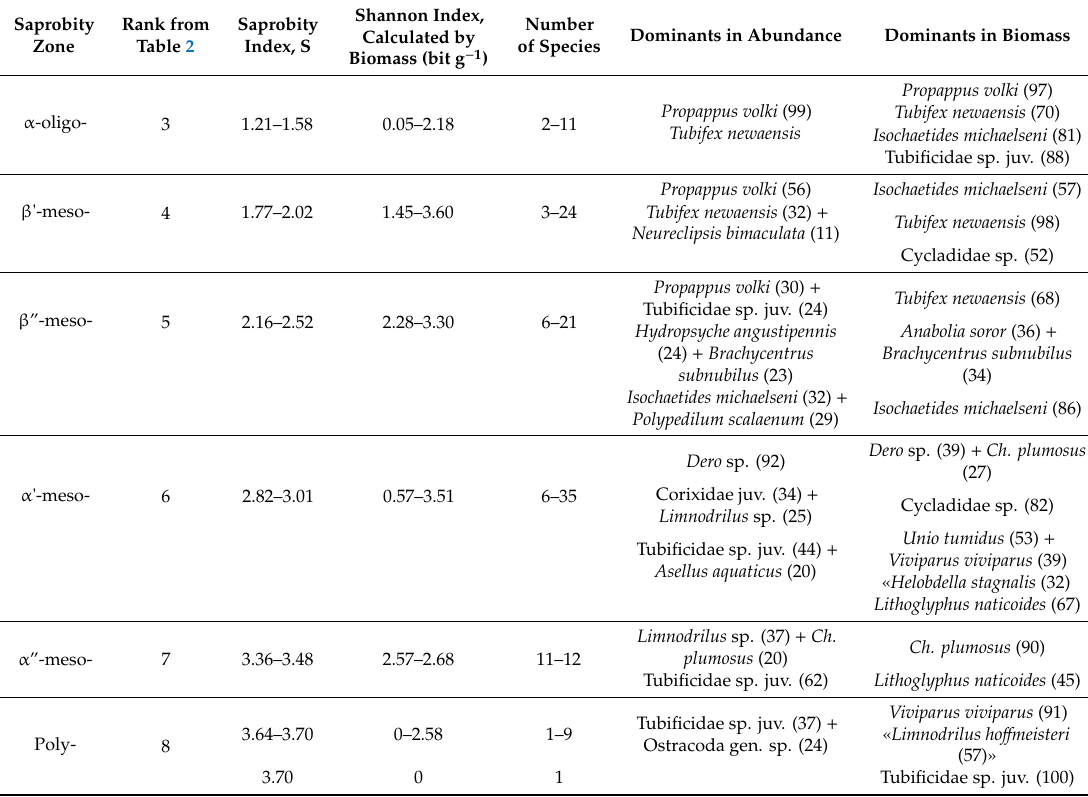
Table 4. Indicators of the structure and composition of zoobenthos communities in the Styr River in di ff erent zones of